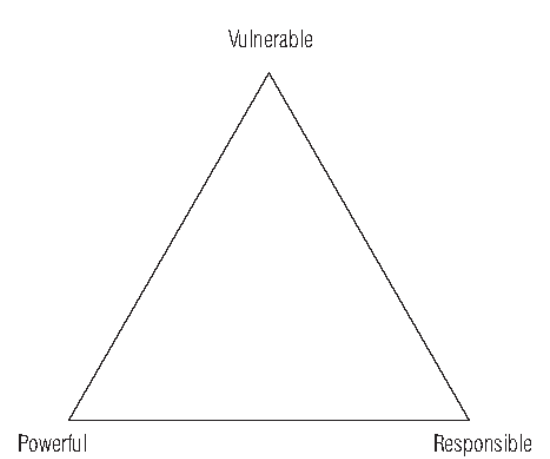
Figure 2: Potency Pyramid (Hay 2009 p. 150)